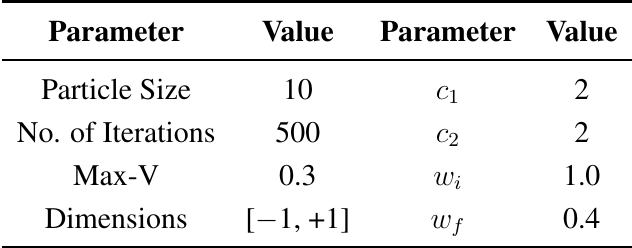
Table 5. Control parameters for the PSO